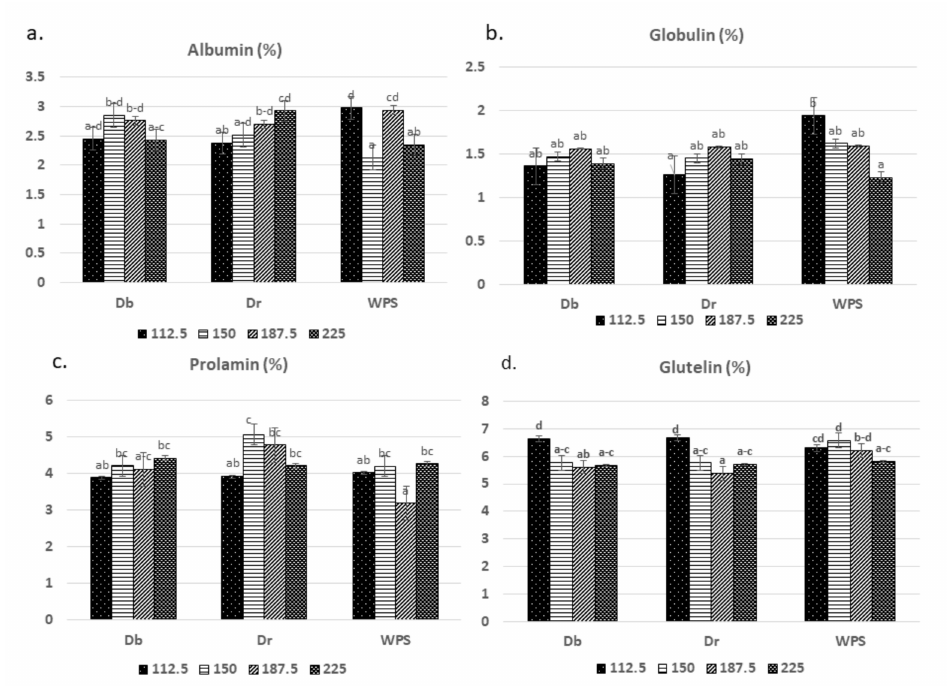
Figure 5. The e ff ects of the sowing methods and seed rate on protein fractions in the first cropping season. ( a – d ) letters represent albumin (%), globulin (%), prolamin (%), and glutelin (%) respectively. Db, Dr, and Wps represent the sowing methods dibbling, drilling, and wide precise sowing, respectively. 112.5, 150, 187.5, and 225 represent the winter wheat (Xinong805), sown at 112.5 kg ha − 1 , 150 kg ha − 1 , 187.5 kg ha − 1 , and 225 kg ha − 1 , respectively. The vertical bars represent the standard errors ( n = 3); in the same protein fraction, the same letters above the bars indicate no significant di ff erences between the di ff erent treatments ( p <